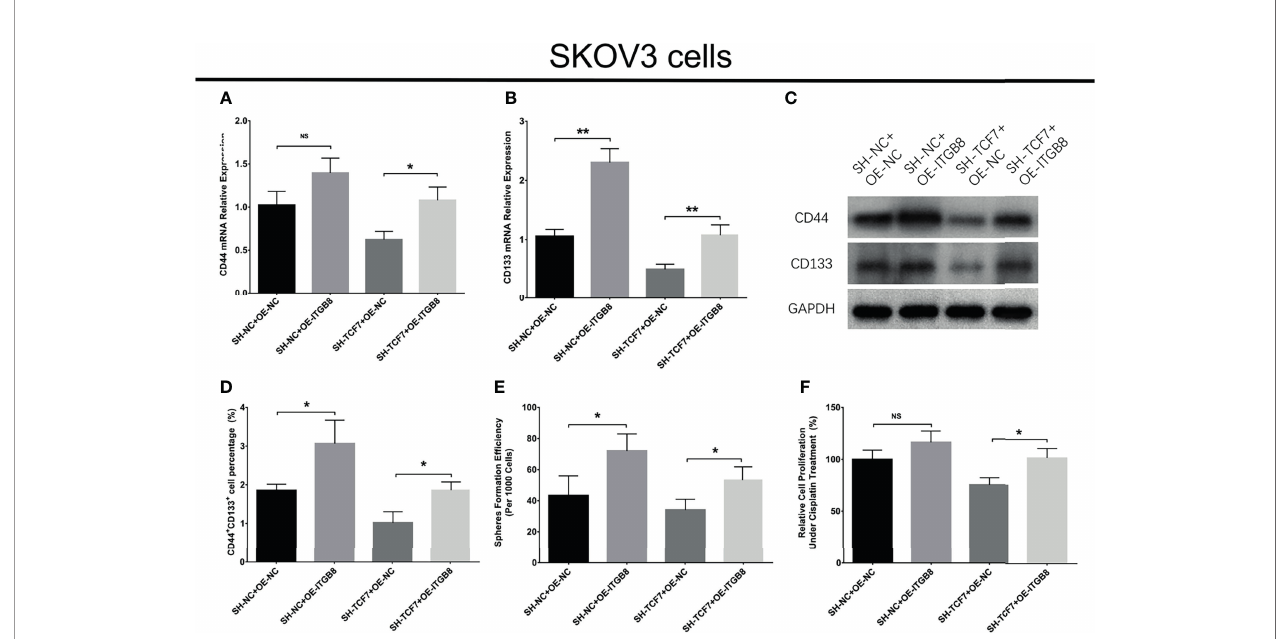
FIGURE 6 | Effect of ITGB8 overexpression on cell stemness and cisplatin sensitivity in SKOV3 cells. CD44 (A) , CD133 (B) mRNA expressions, their protein expressions (C) , CD44 + CD133 + cell percentage (D) , spheres formation ef fi ciency (E) and cisplatin sensitivity (F) after corresponding transfections. Experiments were performed in triplicates. * represented P < 0.05, ** represented P < 0.01, ns represented no signi fi